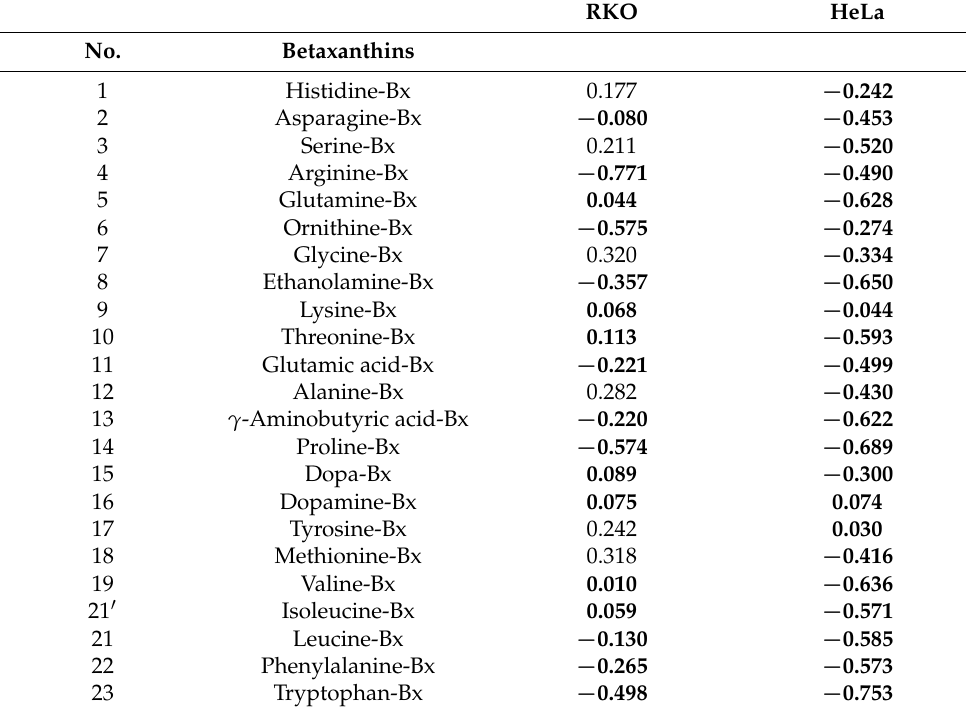
Table 8. Correlation coefficients between identified betaxanthins (absolute peak areas) and microbial activity (CC 50 ). Statistical significance is marked by font: boldface means 95% significance, and normal font lack of significance at